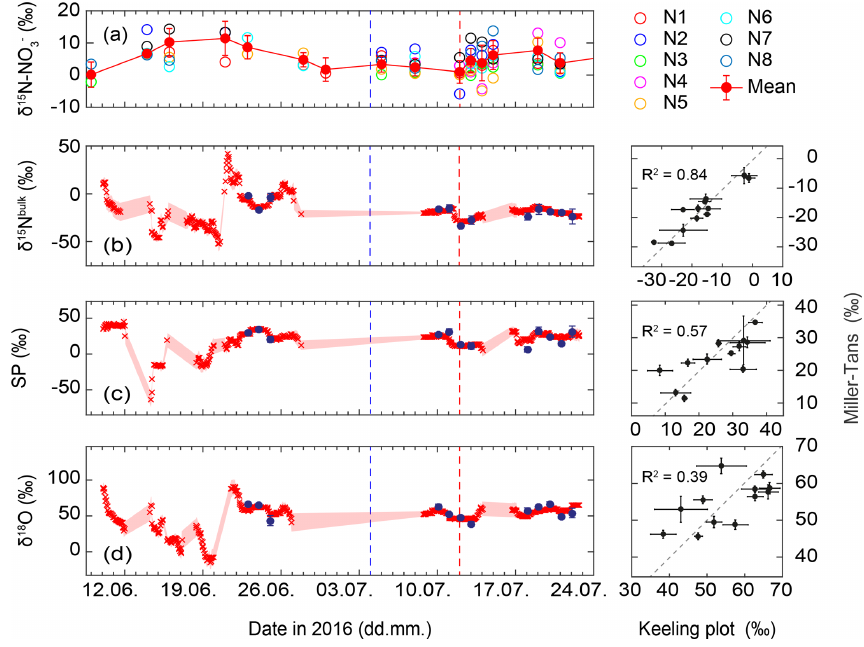
Figure 5. Temporal trend of δ 15 N of soil-extracted NO − at eight different nodes (N1–N8) near the N 2 O flux and isotope measurements at De- 3 Fen, indicating large spatial variability. In (a) , concentration-weighted average values (red filled symbols) and their uncertainty (1 standard deviation) are given. Source signatures (b) δ 15 N bulk , (c) SP and (d) δ 18 O of soil-emitted N 2 O derived from the Miller and Tans (2003) approach (red crosses) and the Keeling (1961, 1958) plot approach (blue filled symbols) are given. Uncertainties are indicated as pale red shaded areas for the Miller–Tans approach and error bars for the Keeling plot approach (1 standard deviation with a Monte Carlo model). The blue dashed line shows the cutting event, while the red dashed line indicates the manure application. Three panels on the right: correlation diagram of results derived from the Miller and Tans (2003) and the Keeling (1961, 1958) plot approaches. The dashed line corresponds to the 1 : 1